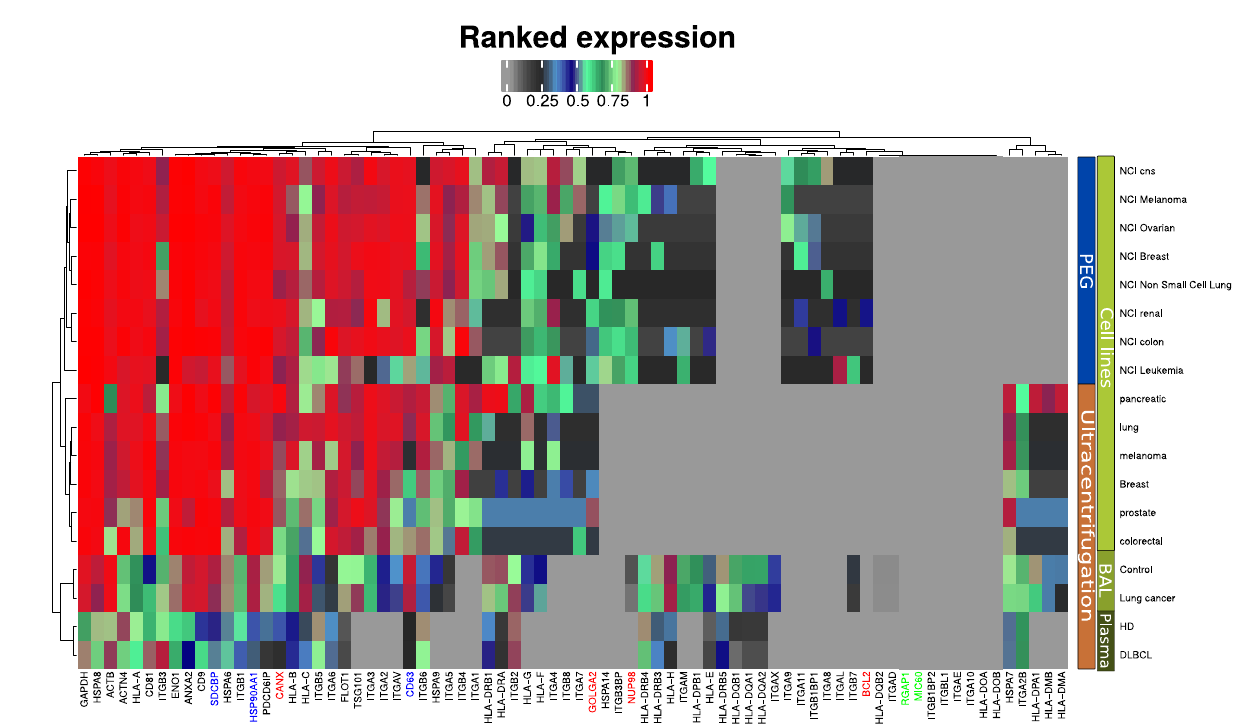
Figure 2. MS-based quantitative comparison between enriched plasma EVs, BAL EVs and cell line isolated EVs of frequently reported exosome protein markers and the ten most abundant exosome markers from a publicly available EV database (ExoCarta). Blue indicates generally accepted exosome markers. Green indicates micro vesicle markers. Red ‐ labeled proteins indicate non ‐ EV proteins.